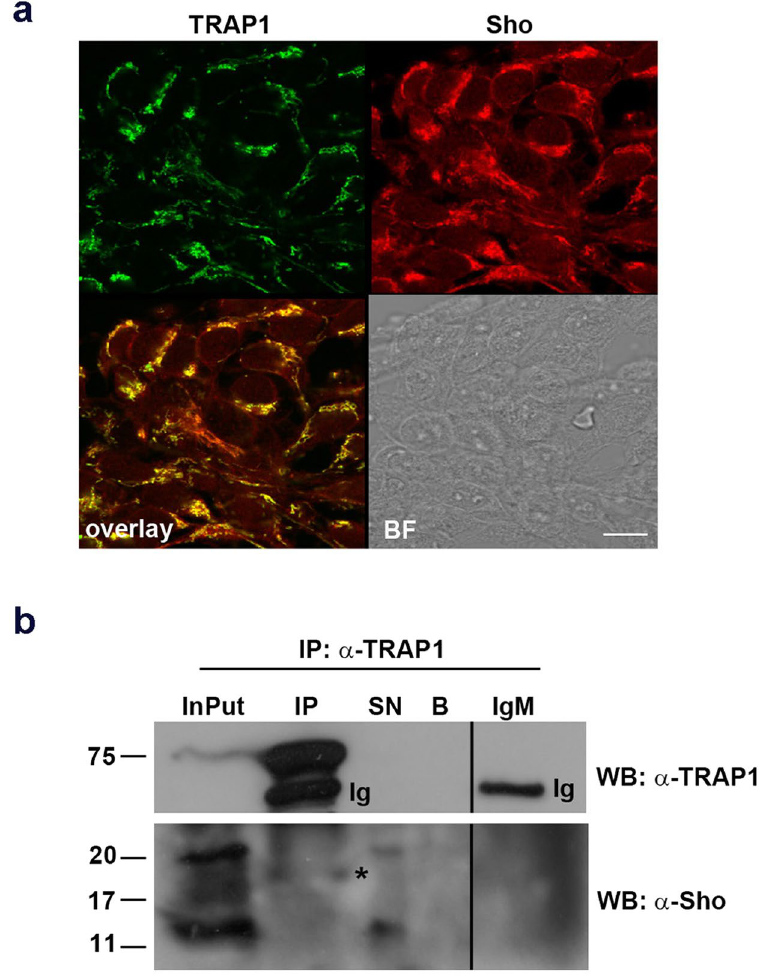
Figure 3. Sho colocalizes with TRAP1 and its 18 kDa isoform co-immunoprecipitates with TRAP1. ( a ) SH- SY5Y cells were grown on coverslips and processed for double immunofluorescence analysis probing with anti-TRAP1 and anti-Sho SPRN-R12 Abs followed by secondary Abs conjugated to Alexa-fluor488 and Alexa- fluor546, to reveal TRAP1 (green) and Sho (red) respectively. Brightfield (BF) and overlay images are shown. Colocalization between TRAP1 and Sho was calculated from three independent experiments as described in methods section. PCC = 0.78 (N = 80 cells). P < 0.05. Scale bars: 10 μ m. ( b ) SH-SY5Y cells were lysed in Buffer 1 and TRAP1 was immunoprecipitated (IP) using the monoclonal anti-TRAP1 Ab (73604 Santa Cruz). The immunoprecipitated material was then immunolabeled with the anti-Sho antibody SPRN-R12. (Ig) indicates the immunoglobulins and ( * ) indicates 18 kDa Sho. To confirm the occurrence of the immunoprecipitation, the membranes were stripped and probed with the anti-TRAP1 antibody. InPut: loading control (50 μ g of total lysate); IP: immunoprecipitate; SN: 1/10 of the supernatant; B: magnetic beads